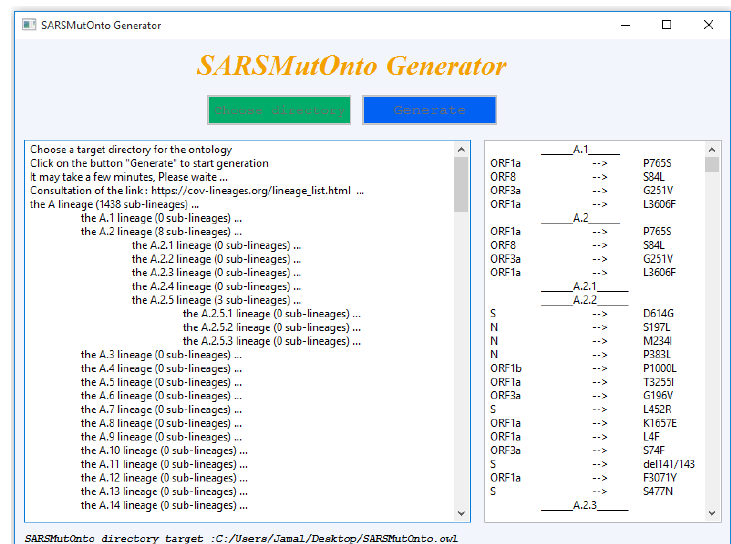
Figure 4. SARSMutOnto Generator: tool used to generate SARSMutOnto.